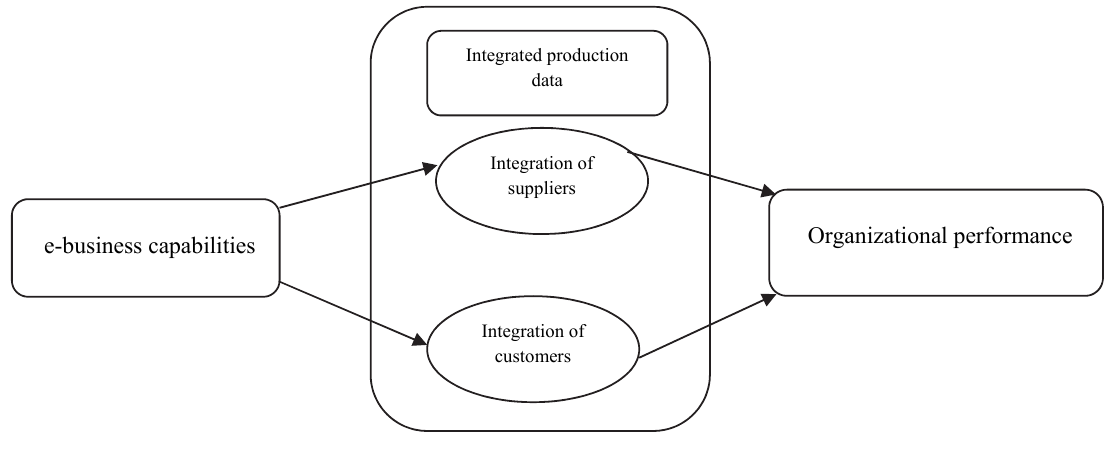
Fig. 1. The proposed model